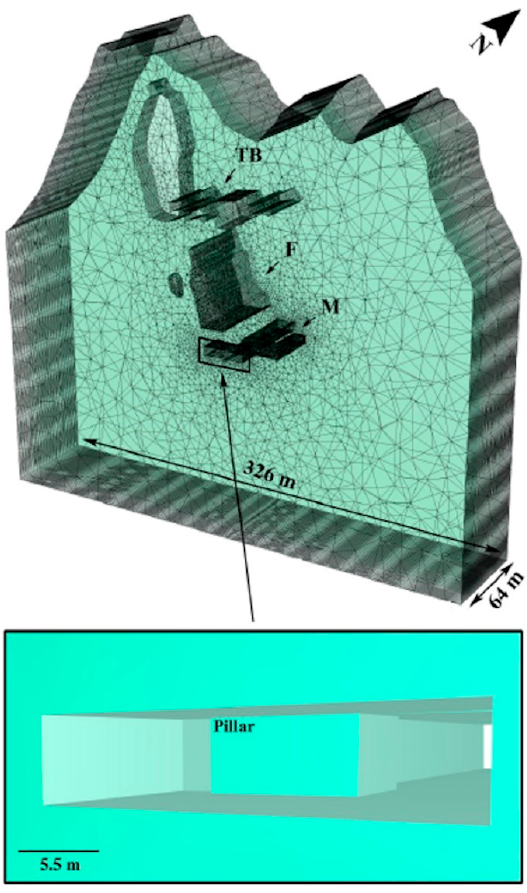
Figure 4. FEM geometry. From the bottom to the top, it is possible to recognize the Macchietta quarry (M), the Fitta quarry (F) and the Tacca Bianca quarry (TB). Being a perspective view, the scale bars are indicative only.